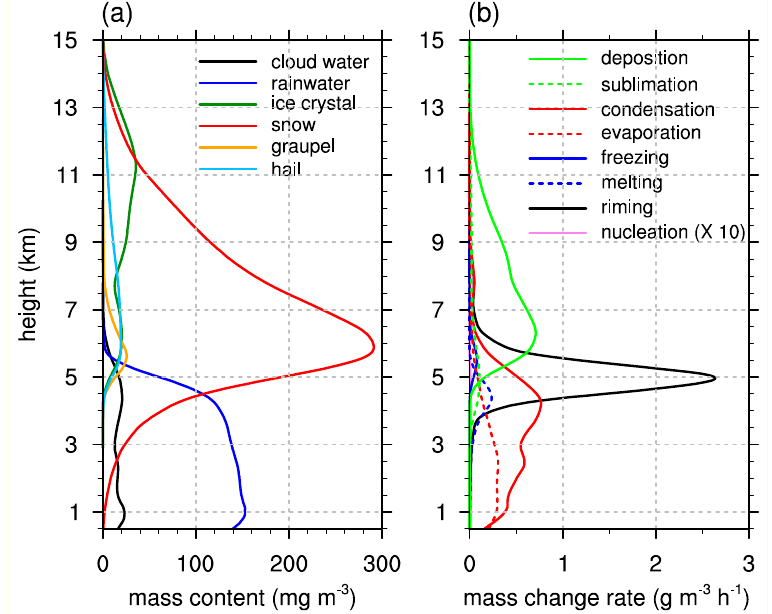
Figure 8. Vertical profiles of ( a ) hydrometeor mass contents and ( b ) mass change rates attributable to microphysical processes in the N 0 = 800 cm − 3 case.